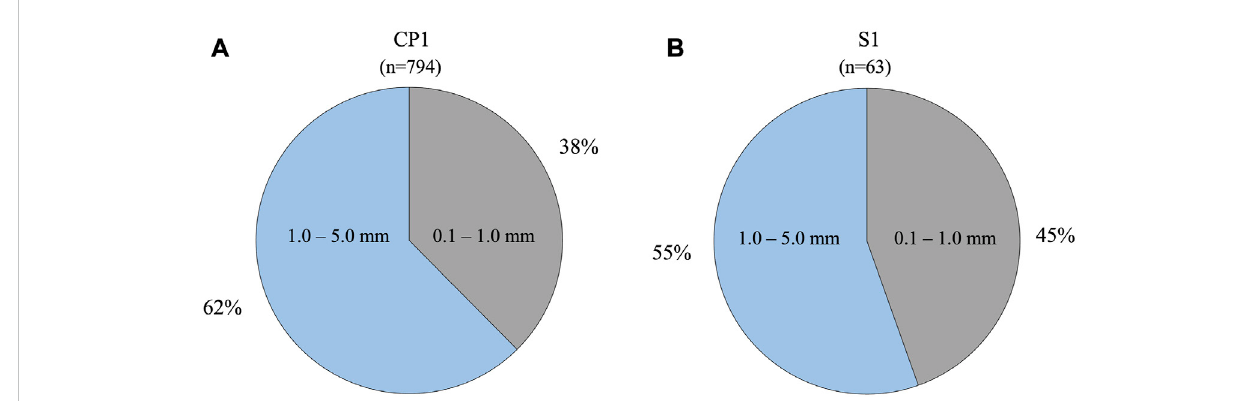
FIGURE 6 Sizes of microplastics in the sediment cores: Percentage proportions of microplastic size in (A) the CP1 sample and (B) in the S1 sample.